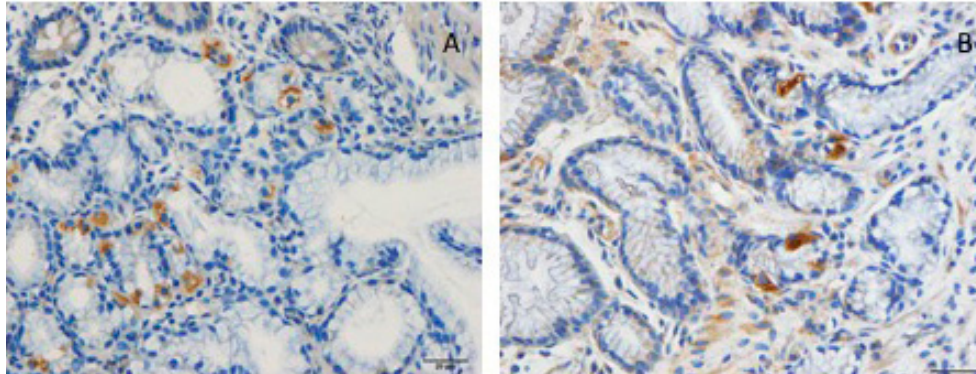
Figure 4. Musashi 1 cells in the duodenum of a healthy subject ( A ) and in the duodenum of a patient with IBS ( B ). Musashi 1 is a marker for stem cells and their early progenitors. Accordingly, it is probable that a low number of these in the stem cells and enteroendocrine cells progenitors might be responsible for the low density of gut endocrine cells [149].